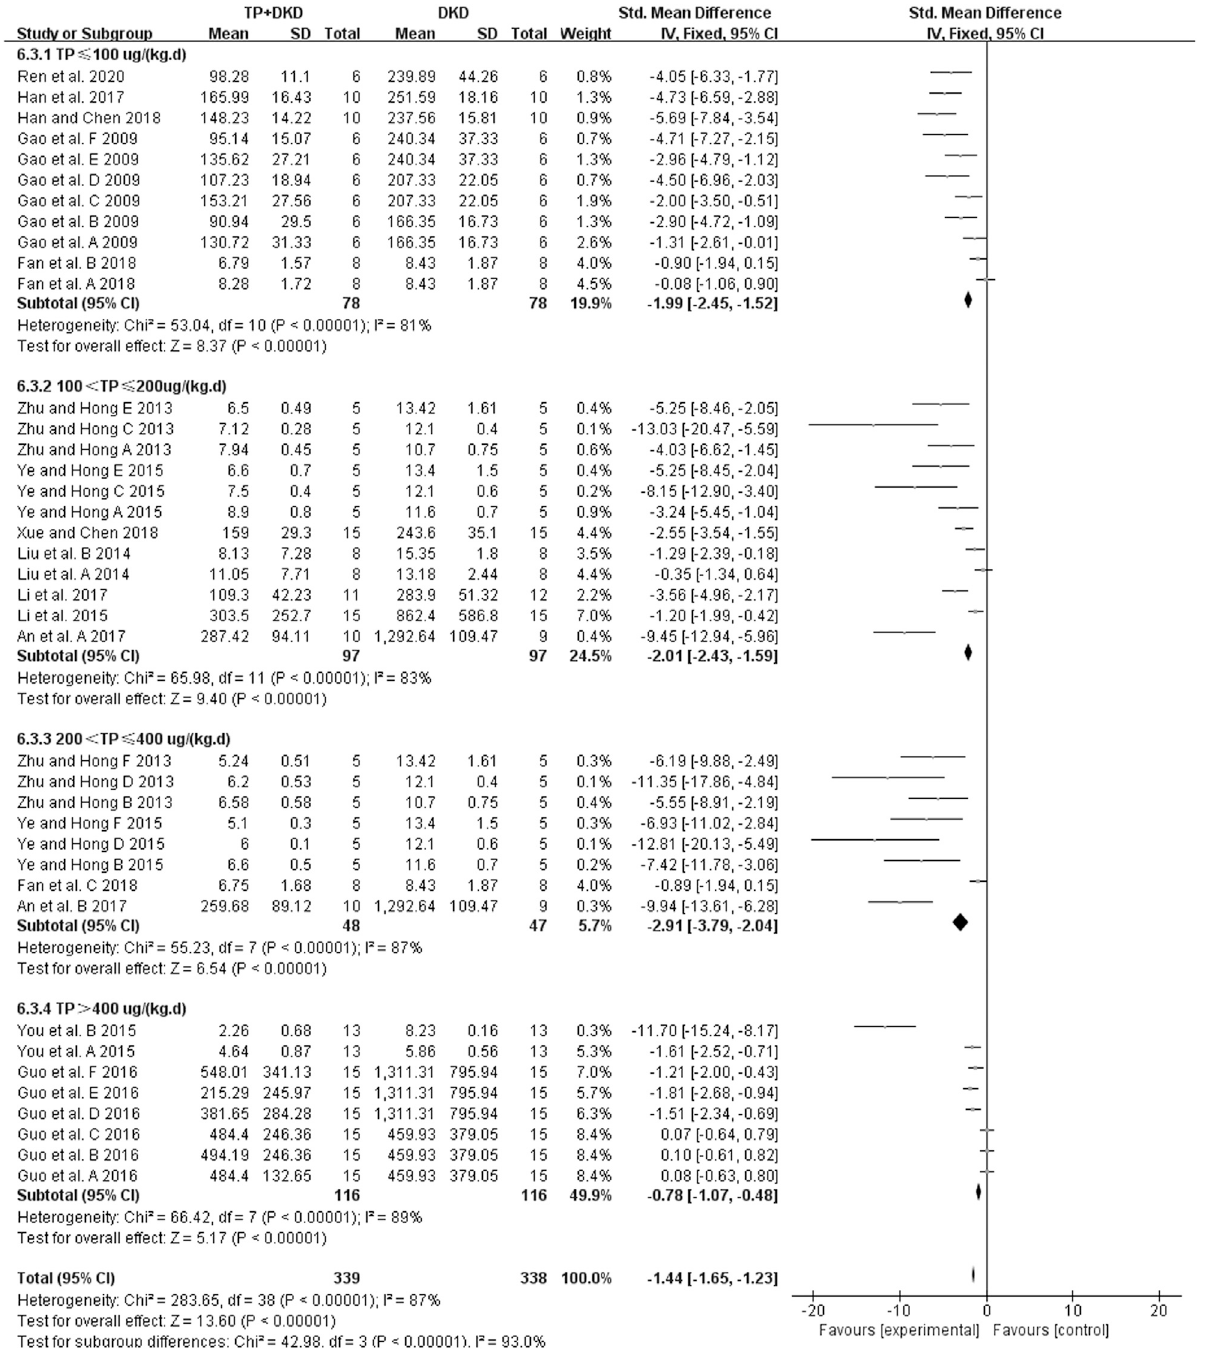
FIGURE 3 | Forest plot of albuminuria